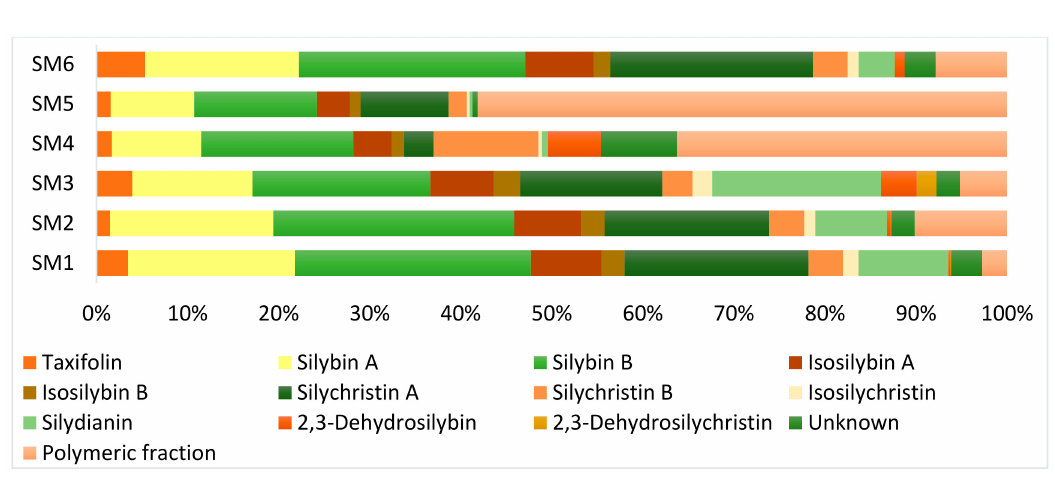
Figure 5. Percentage of individual components in silymarin preparations SM 1–SM 6.